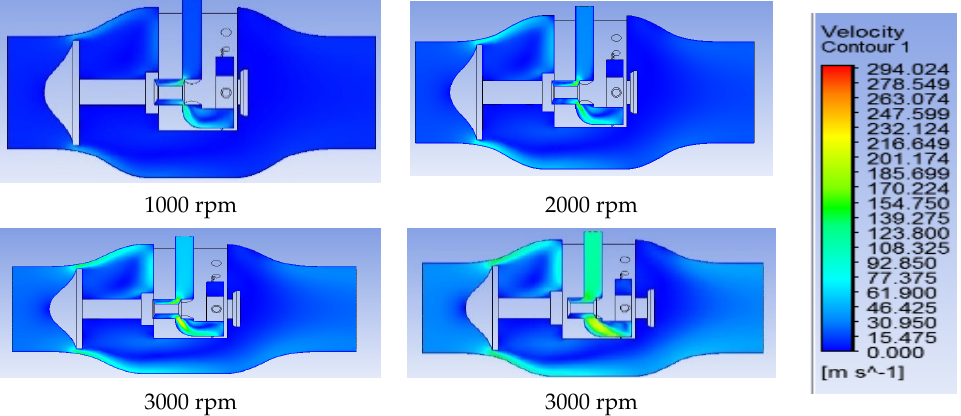
Figure 24. Distribution of velocity on YZ plane inside the new mixer according to different engine speeds and constant air-CNG ratio (34.15)